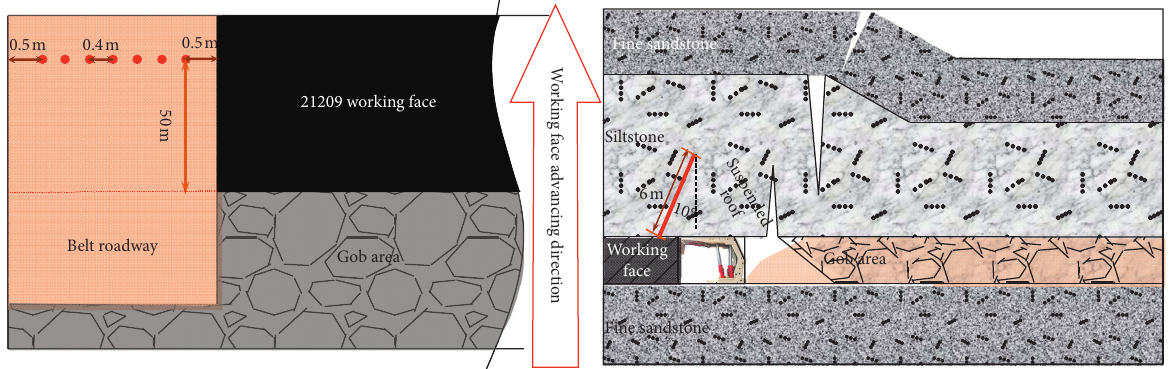
Figure 13: Site construction plan. Left: top view of hole arrangement; right: side view of hole arrangement.